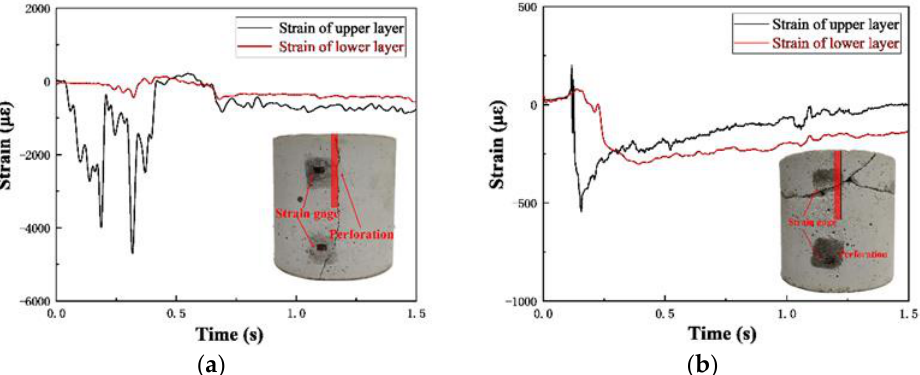
Figure 12. Strain differences between upper and lower layers of ( a ) specimen A1 and ( b ) specimen B1.